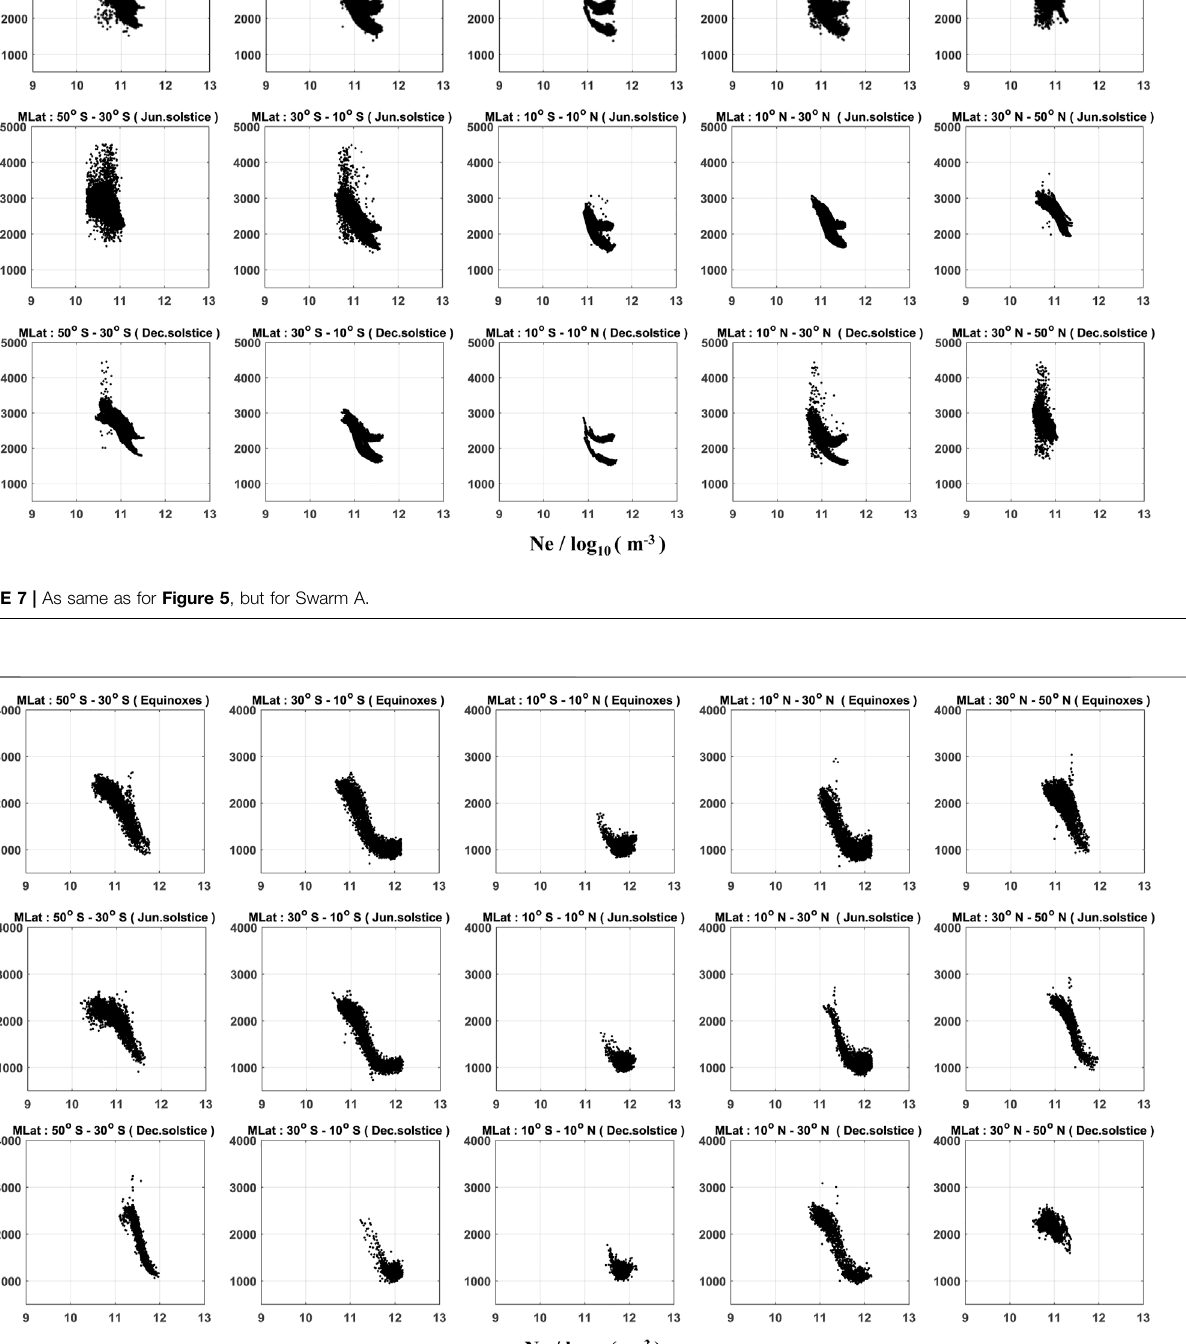
Frontiers in Earth Science |